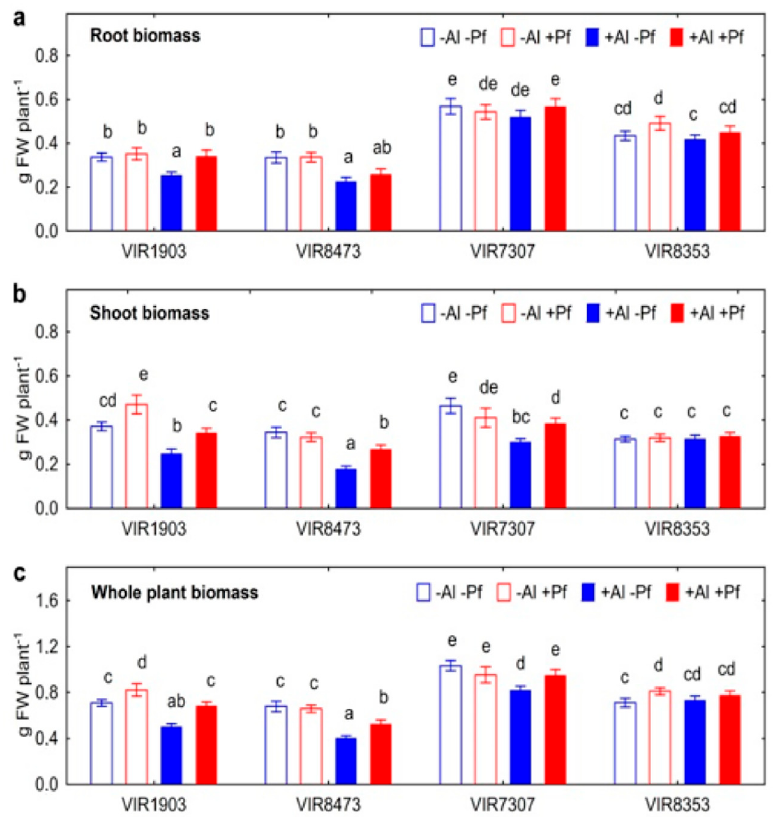
Figure 4. Root ( a ), shoot ( b ) and whole plant ( c ) biomass of pea genotypes VIR1903, VIR8473, VIR7307 and VIR8353 inoculated with Pseudomonas fluorescens SPB2137 and treated with 80 µm AlCl 3 . Treatments: − Al − Pf—Al-untreated and uninoculated control plants, − Al+Pf—Al-untreated and inoculated plants, +Al − Pf—Al-treated and uninoculated plants, +Al+Pf—Al-treated and inoculated plants. Vertical bars show standard errors. Different lowercase letters show significant differences between treatments (least significant difference test, p < 0.05, n varied from 16 to 24 depending on pea genotype and treatment). FW stands for fresh weight.